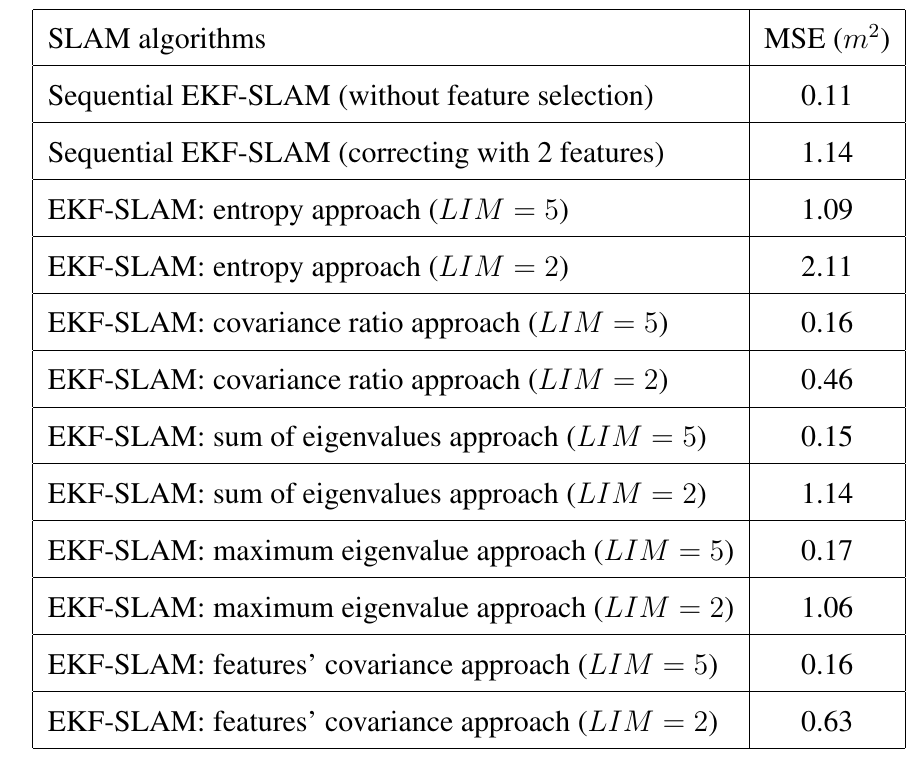
Table 1. Mean Square Error associated with the different SLAM algorithms with feature selection